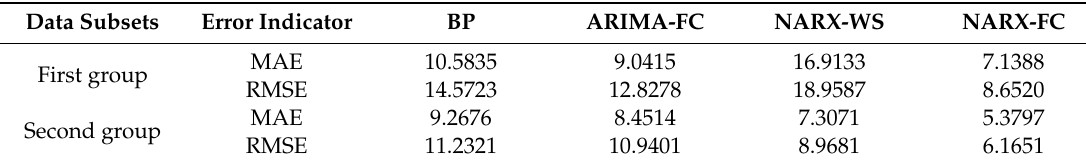
Table 3. Error evaluation indicator of the prediction results of SO 2